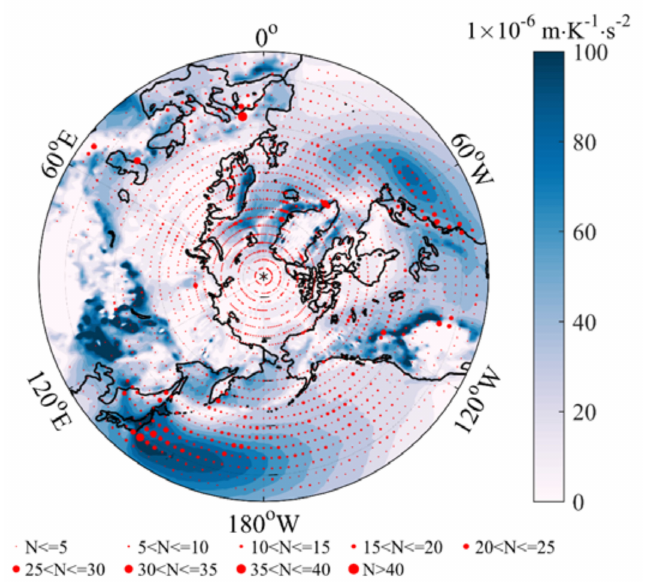
Figure 1. Distributions of atmospheric baroclinic index (blue shading, unit: 1 × 10 − 6 m · K − 1 · s − 2 ) and the number of the cyclone centers on the onset day (red dots) in the northern hemisphere in winters of the period 1979–2017. The size of the red dots denotes the number of the cyclones.